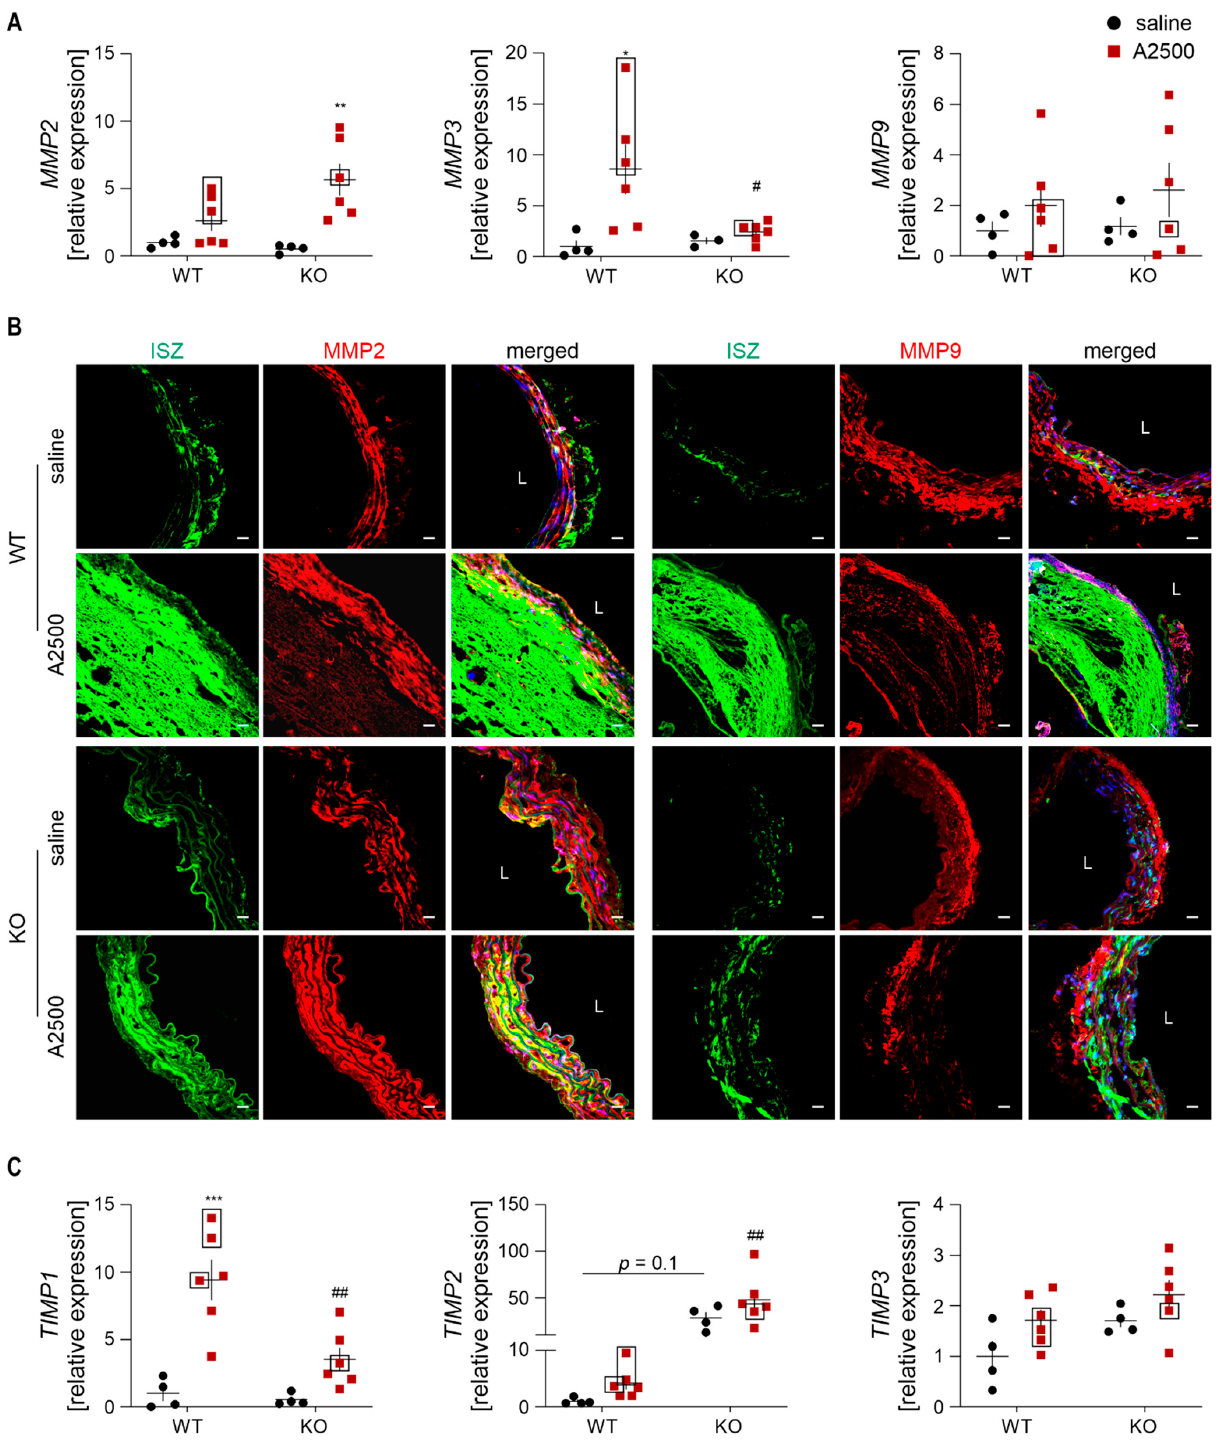
Figure 10. MMP2 and TIMP2 are strongly upregulated upon AngII in HO-1-deficient mice. ( A ) Relative expression of MMP2 , MMP3 , and MMP9 in the abdominal aortic wall. eEF2 was used as a reference gene. Two-way ANOVA with Tukey’s post hoc test; * p < 0.05 vs. saline, ** p < 0.01 vs. saline, # p < 0.05 vs. WT. Rectangle—mice which developed the aneurysm; ( B ) The activity of gelatinases (green) and MMP-2/MMP-9 level (red). Blue—nuclei. The activity of gelatinases was assessed by in situ zymography. Representative images. Scale bar = 30 µm; L—lumen; ( C ) Relative expression of TIMP1 , TIMP2 , and TIMP3 in the abdominal aortic wall. eEF2 was used as a reference gene. Two-way ANOVA with Tukey’s post hoc test; *** p < 0.001 vs. saline, ## p < 0.01 vs. WT.; Rectangle—mice which developed the